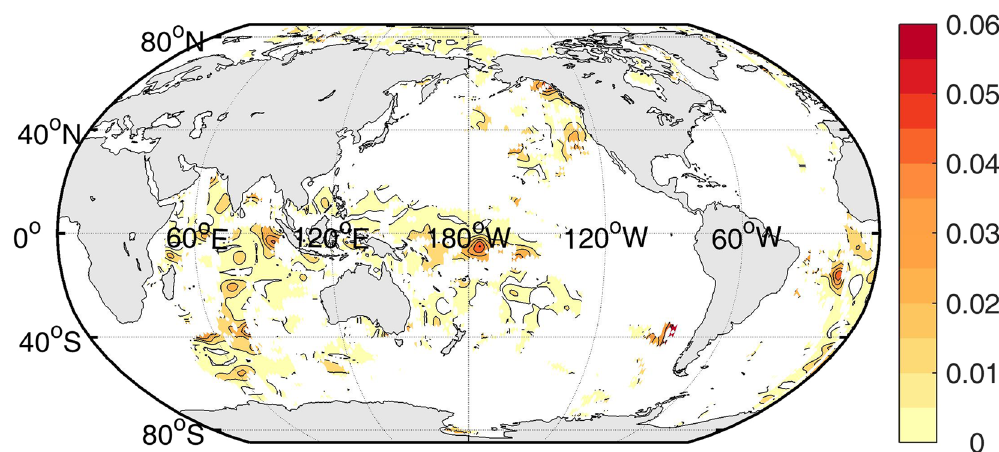
Figure 2. The original incorrect version of Figure